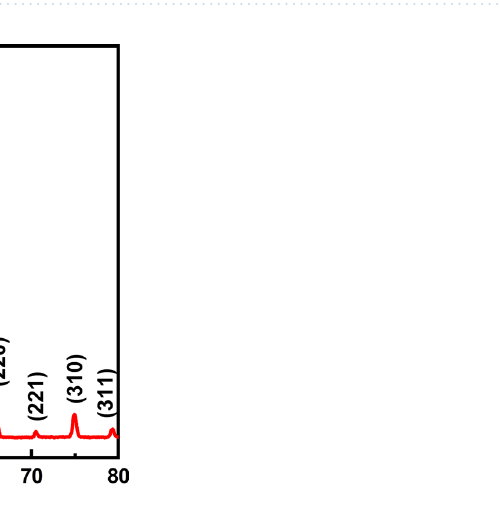
Figure 4. TEM images of BCZT powders synthesized at 180 °C for 60 min: ( a ) TEM image of BCZT powders; ( b ) high-resolution stripes.